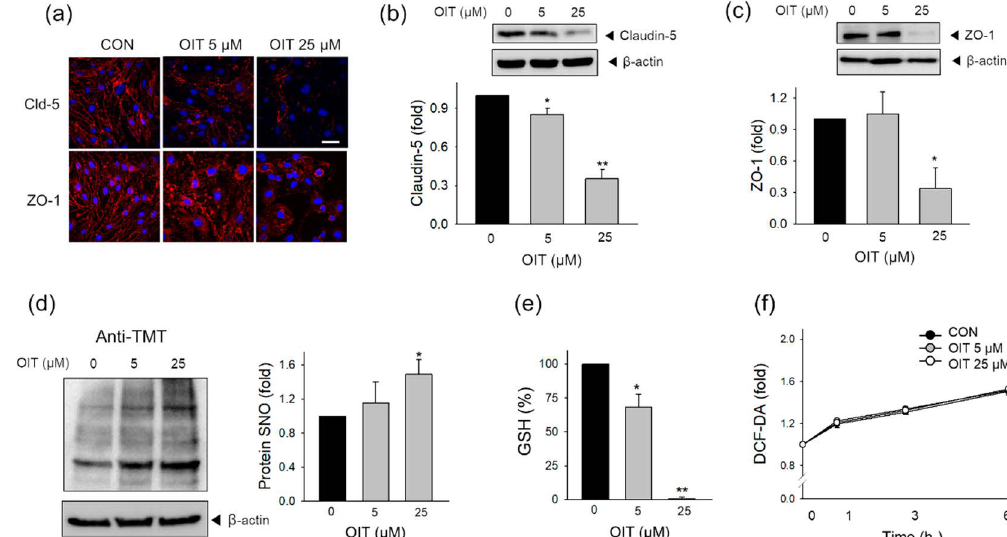
Figure 2. Effects of OIT on tight junction protein expression, protein S-nitrosylation (SNO), reduced glutathione (GSH), and total cellular ROS levels. ( a ) Immunofluorescence staining with claudin-5 or ZO-1 was performed in the OIT-exposed bEnd.3 cells and visualized by confocal microscopy at 24 h after OIT treatment ( n = 3). Scale bar: 20 μm. ( b , c ) The protein levels of ( b ) claudin-5 and ( c ) ZO-1 were determined 24 h after treatment with 5 and 25 μM OIT ( n = 3). ( d ) The level of SNO-modified proteins was detected at 1 h after treatment with 0, 5, or 25 μM OIT by the detection of the TMT-labeled S-nitrosylated proteins in western blot ( n = 3). ( e ) The level of reduced GSH was measured at 24 h after treatment with OIT ( n = 3). ( f ) Total cellular ROS was detected at 0, 1, 3, and 6 h after treatment with OIT ( n = 3). Data are presented as mean ± SEM. * p < 0.05, ** p < 0.01 vs. CON (control).